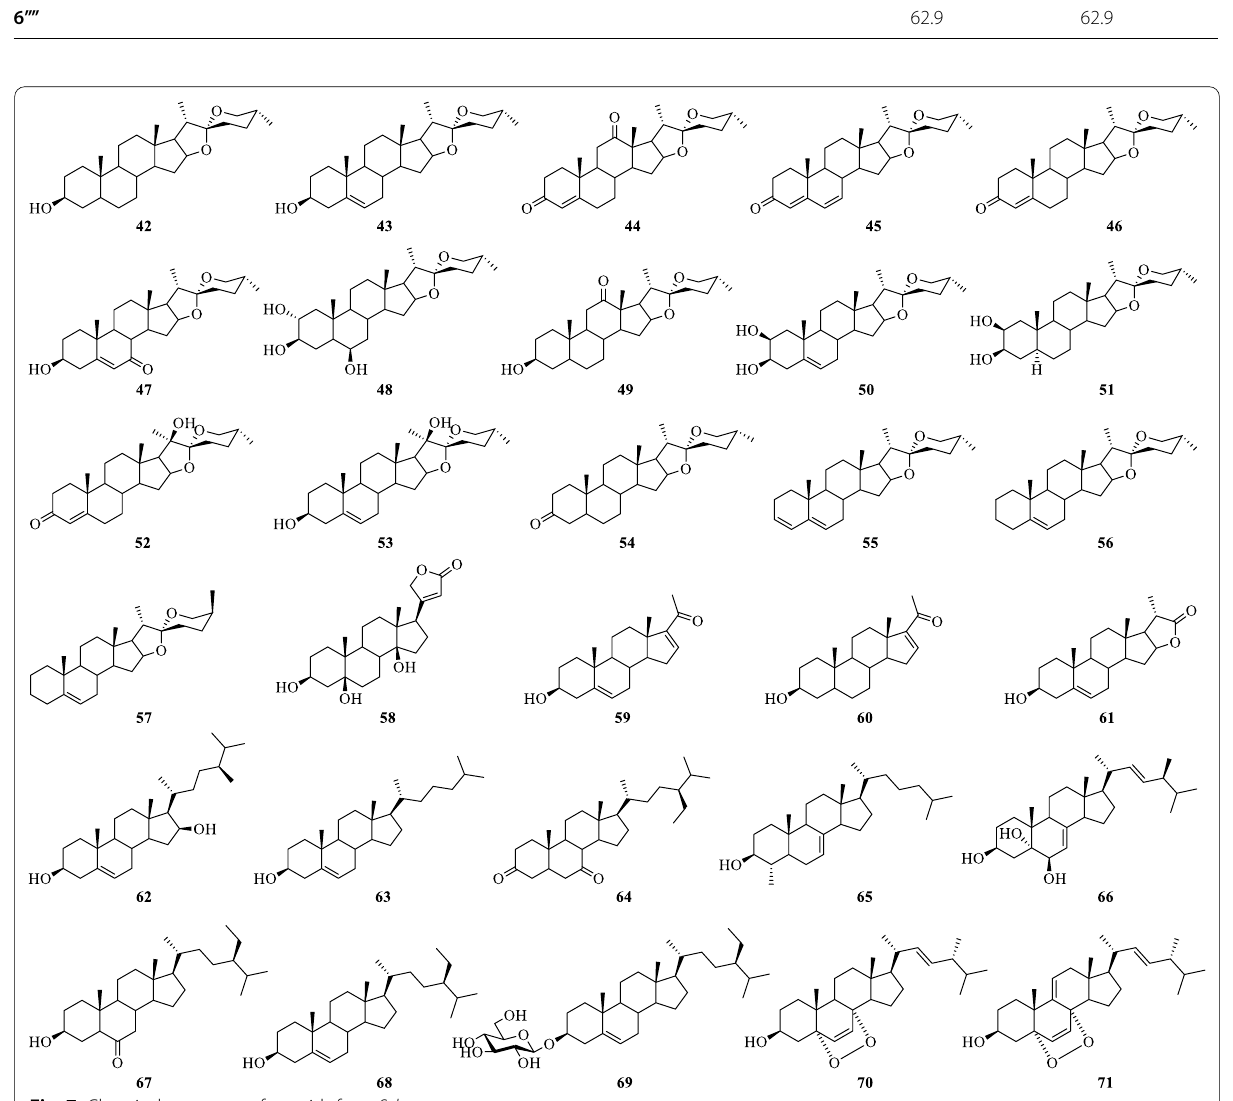
Fig. 7 Chemical structures of steroids from S.